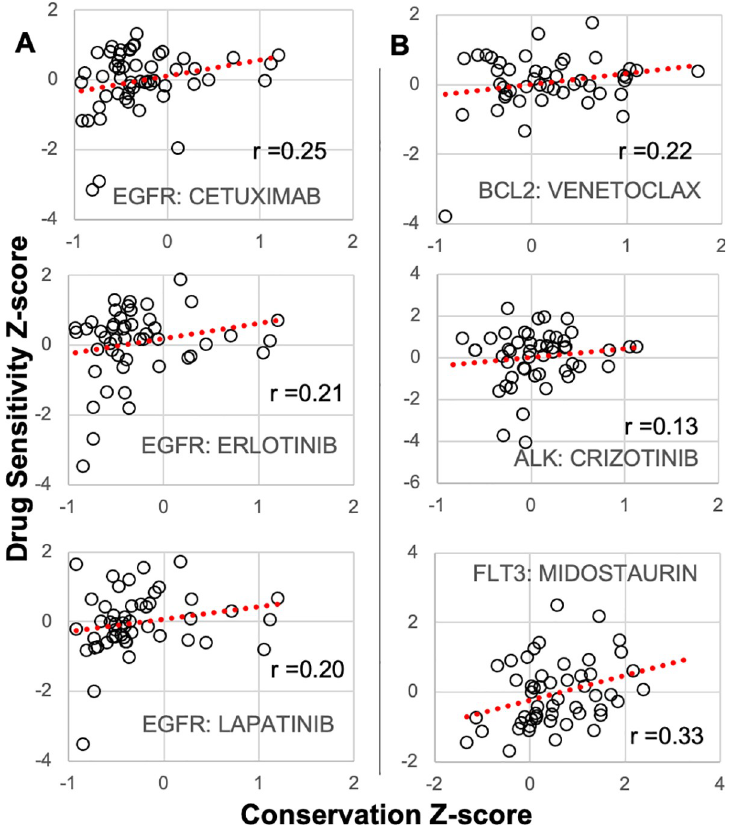
Fig 4. Gene conservation signals drug vulnerabilities. A) Targeted EGFR drug sensitivities (z-scores, negative values more drug sensitive) correlated with EGFR conservation (z-scores, negative values more conserved). Most drug sensitive cell lines showed preferential targeted gene conservation with r-shaped distributions. B) Conservation of BCL2 (venetoclax), ALK (crizontinib), and FLT3 (midostaurin) correlated with their cell line targeted therapy